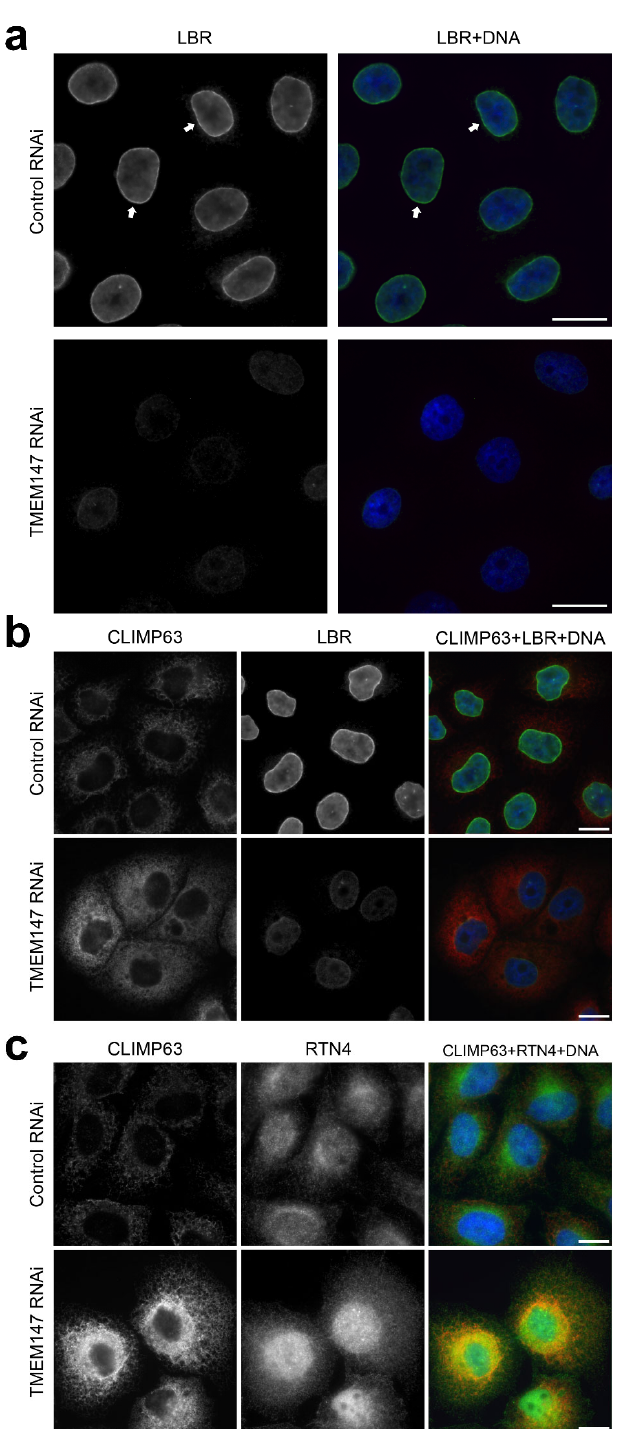
Figure 1. Immunofluorescence imaging of TMEM147 silencing in HeLa cells. ( a ) Cells stained for LBR and DNA show downregulation of LBR expression in response to TMEM147 silencing, in line with [8]; arrows indicate the nuclear rim on the inner nuclear membrane; ( b ) cells stained for CLIMP63, LBR and DNA; ( c ) Cells stained for CLIMP63, RTN4 and DNA. For ( b , c ), TMEM147-silenced cells show elevated fluorescence intensity and area for the respective ER marker. Size markers indicate 20 µ